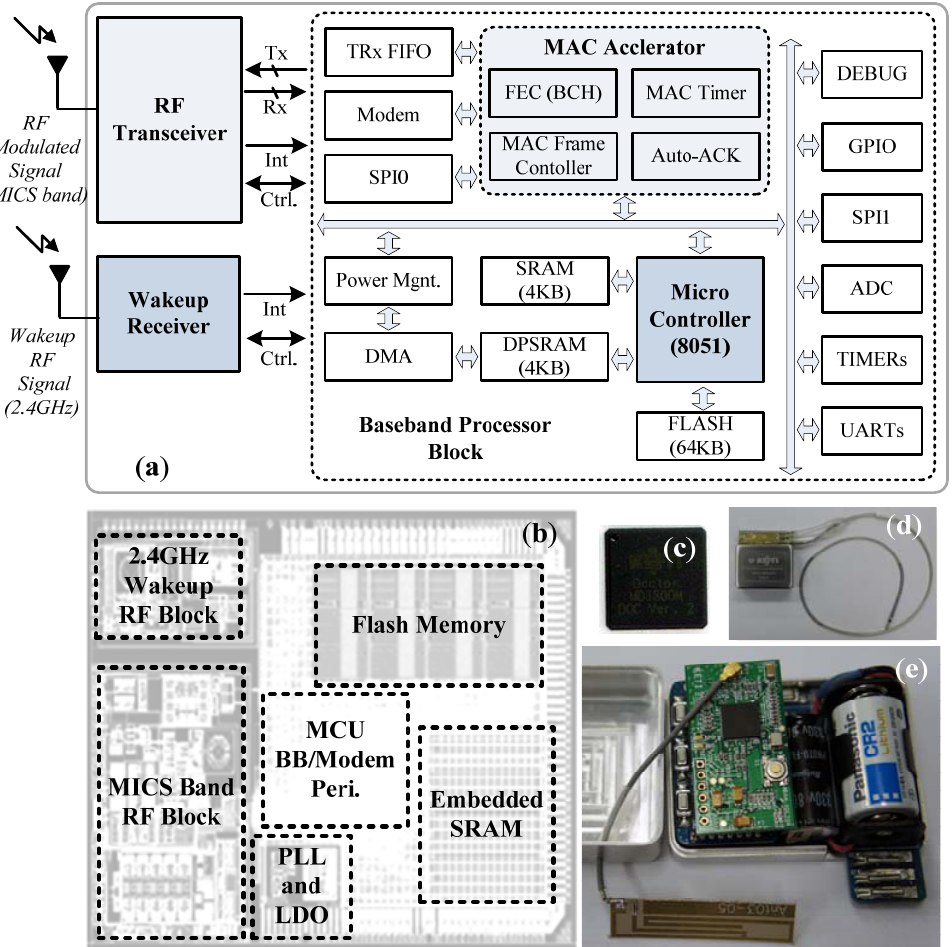
Figure 8. Hardware platform with an SoC for implanted medical devices. ( a ) Internal block diagram of the SoC. ( b ) SoC layout. ( c ) WBAN SoC. ( d ) Bipolar lead connection to the implant defibrillation device (medical Ti case, 56 × 43  ×  22 mm). ( e ) Modules for arrhythmia detection/defibrillation (ECG/EMG signal analyser/650 V stimulation), and the transceiver SoC module.